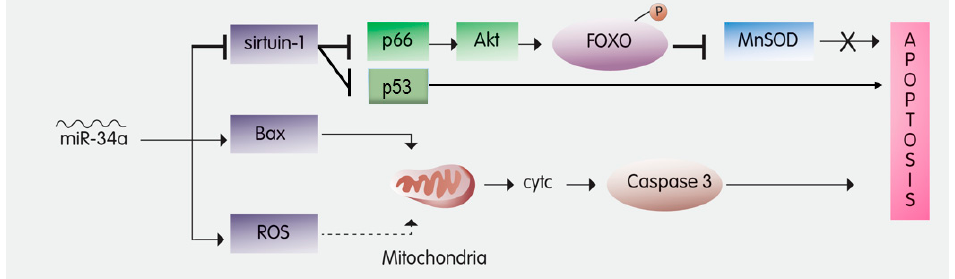
Figure 1. The role of miR-34a in inducing apoptosis—miR-34a induces apoptosis by inhibiting Sirtuin-1. Sirtuin-1 attenuates apoptosis by: 1—Inhibiting p66, an activator of Akt; Akt phosphorylates FOXO to inhibit MnSOD, which usually inhibits apoptosis. 2—inhibiting the transcription of p53, which usually induces apoptosis. In addition, miR-34a leads to Bax upregulation and reactive oxygen species (ROS) accumulation, hence triggering the release of Cytochrome C from the mitochondria, which activates Caspase 3 to induce apoptosis. FOXO3: Forkhead box O3; MnSOD: Manganese Superoxide Dismutase; Akt: protein kinase B; cytc: Cytochrome c.